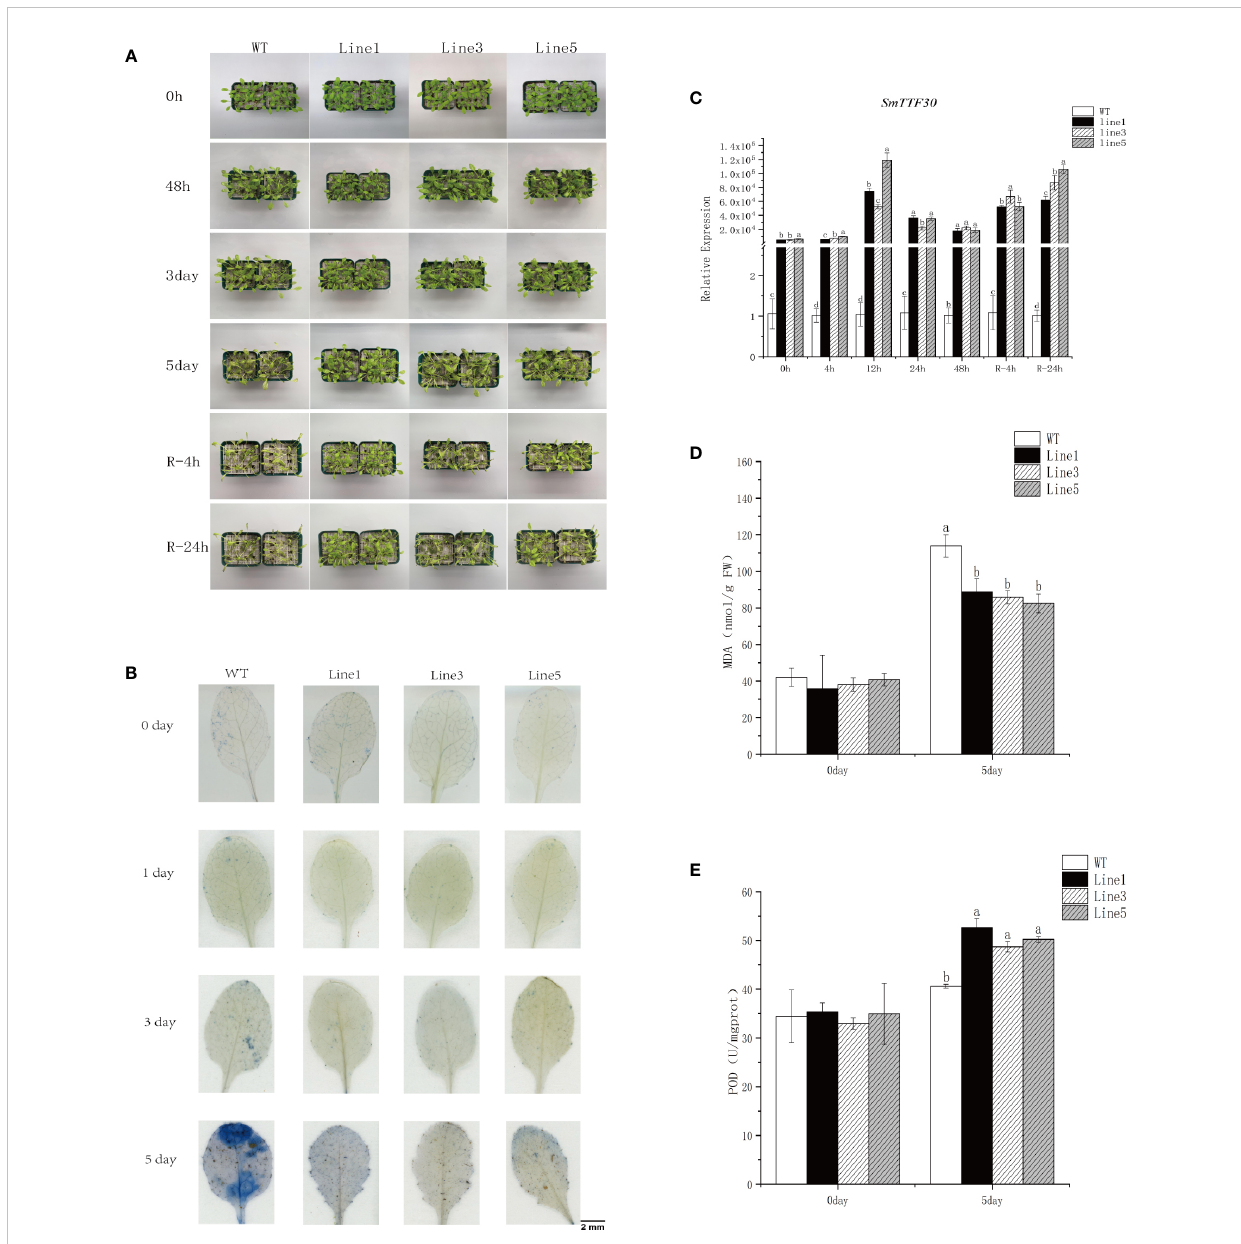
FIGURE 9 Submergence tolerance assay of SmTTF30 overexpression lines (Line1, Line3, Line5) and wild type (WT). (A) Five-week-old plants were subjected to submergence stress for 6 days. (B) Evans blue staining. (C) qRT-PCR analysis of transgenic and wild-type plants. (D) MDA content. (E) POD activity. The mean value and standard deviation were obtained from three independent experiments. The data represent the mean ± SD of three biological repeats with three measurements per sample. Data were analyzed by one-way analysis of variance followed by Duncan ’ s test. Different letters represent statistically signi fi cant differences ( p <